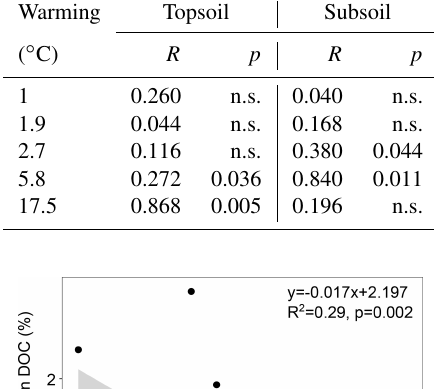
Table 2. Summary of the analysis of similarity (ANOSIM) that tested the differences in the distribution of SOC in the investi- gated fractions for all warming intensities against the unwarmed reference. p values < 0.05 indicate significant differences, whereas “n.s.” indicates nonsignificant differences. An R value close to 1 suggests dissimilarity between groups. Warming Topsoil